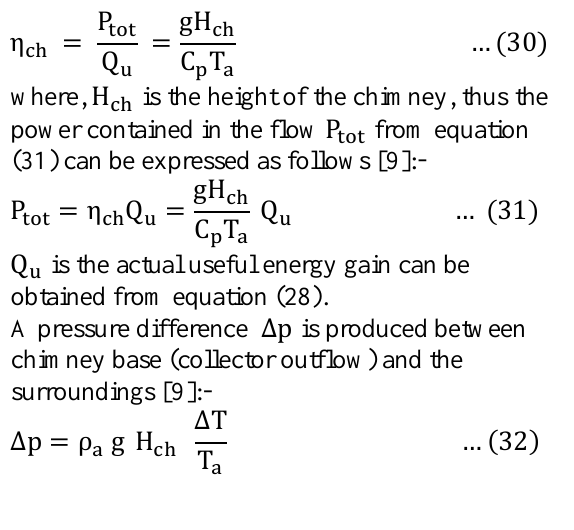
Fig. 5. Mesh of reduction area for the solar chimney model.